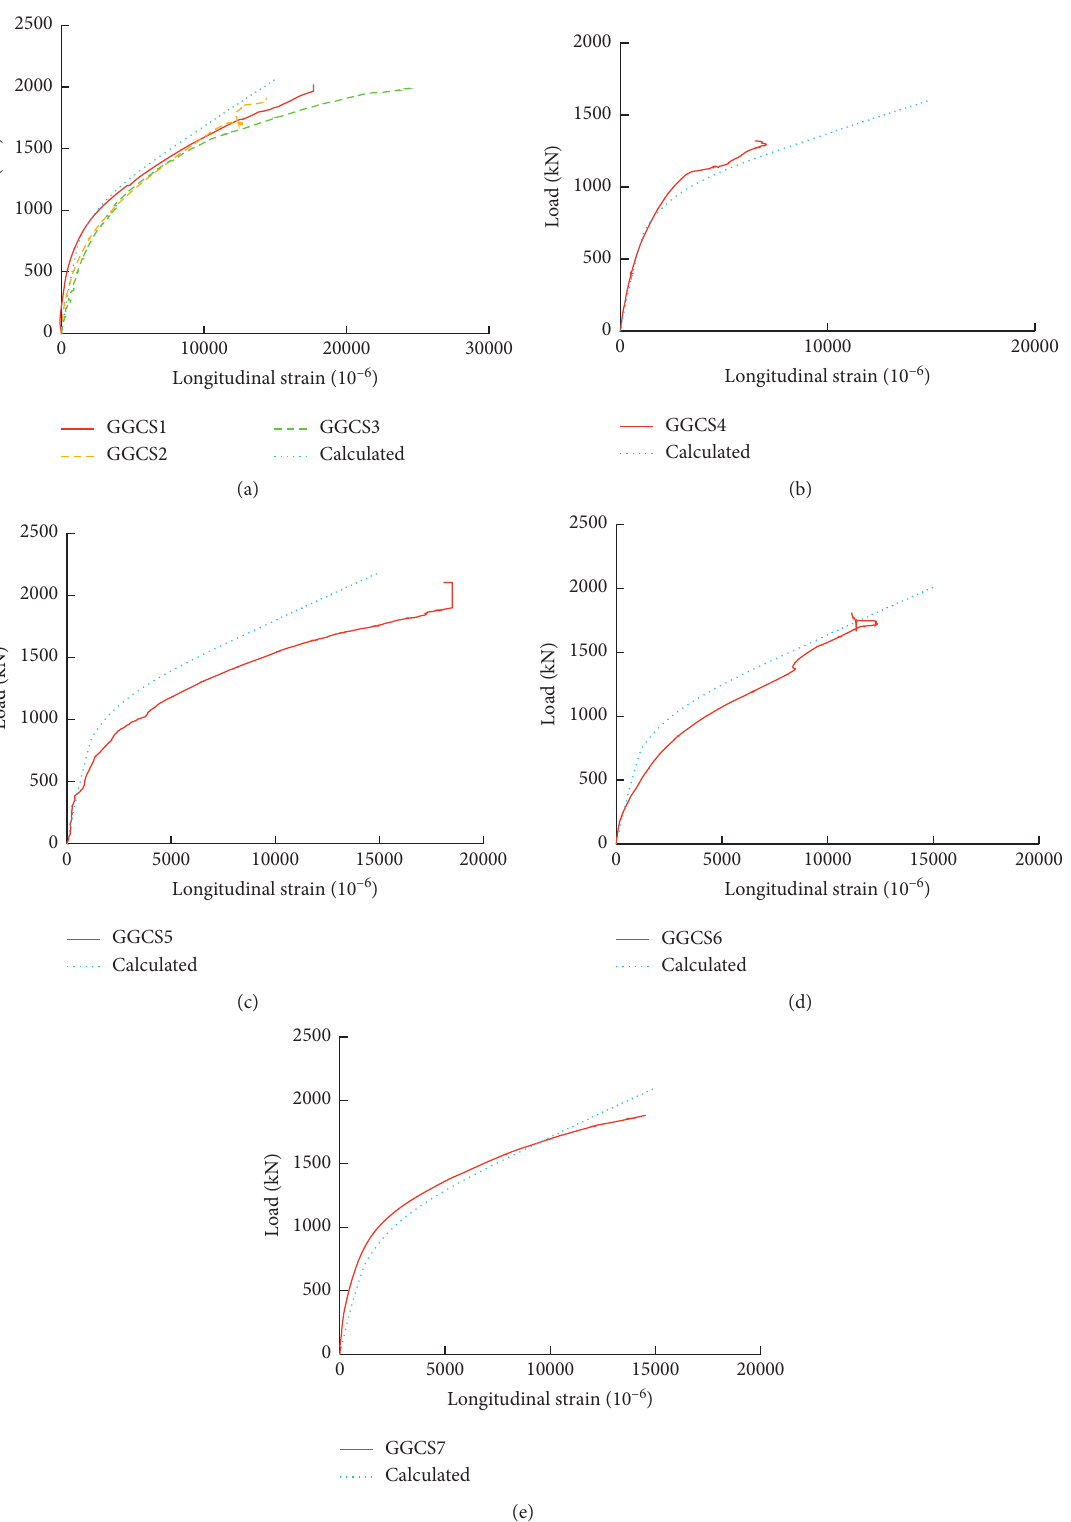
Figure 8: Comparison between calculation and test curves. (a) GGCS1, GGCS2, and GGCS3. (b) GGCS4. (c) GGCS5. (d) GGCS6. (e)